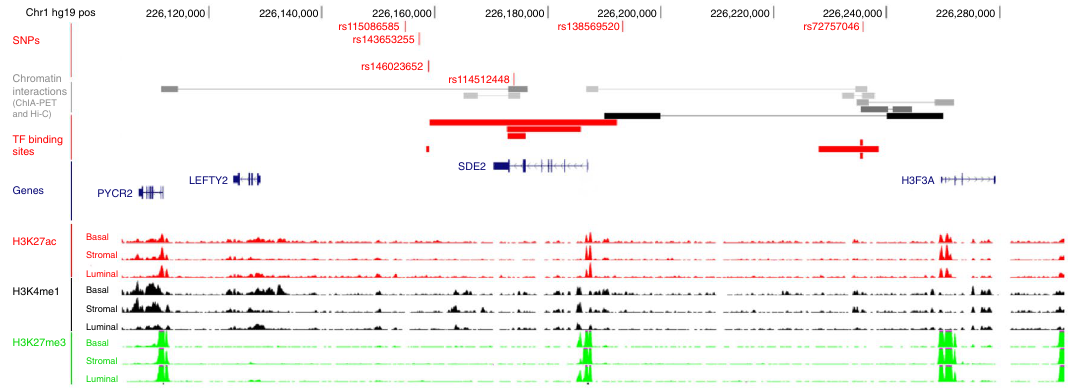
Figure 2. Functional annotation of the six highly correlated SNPs: rs138569520, rs146023652, rs114512448, rs143653255, rs115086585 and rs72757046. TF transcription